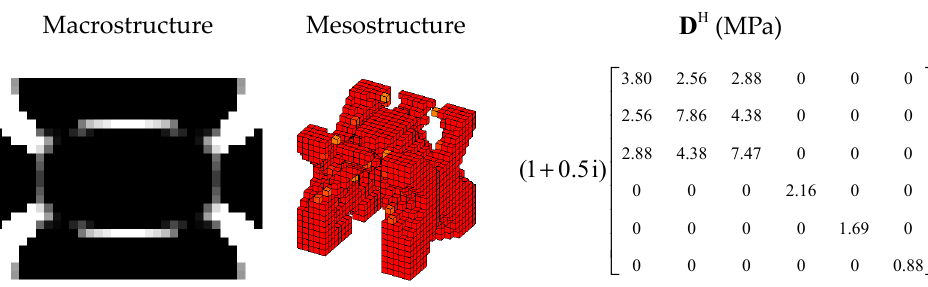
Figure 10. Optimization results designed from initial guess design 2.